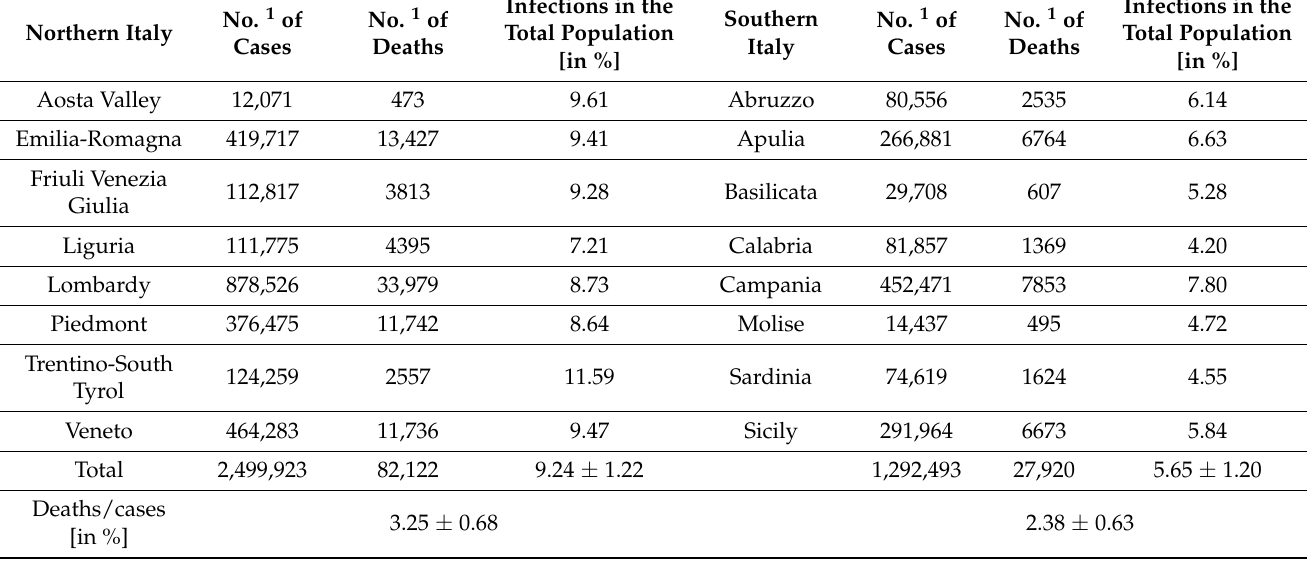
Table 3. Epidemiological data in northern and southern Italy.